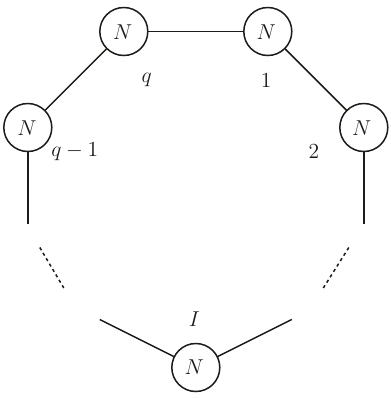
Figure 1. The circular quiver with q nodes associated to the theory A q − 1